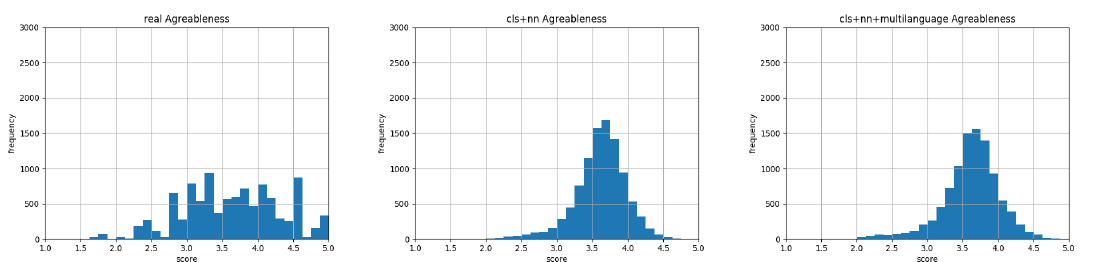
Figure 13. Extraversion: Histograms representing data distribution of gold standard on the left, our English model result in the middle, and our multilingual model result on the right.